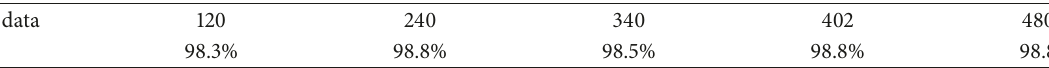
Table 7: Training accuracy with different number of training data.